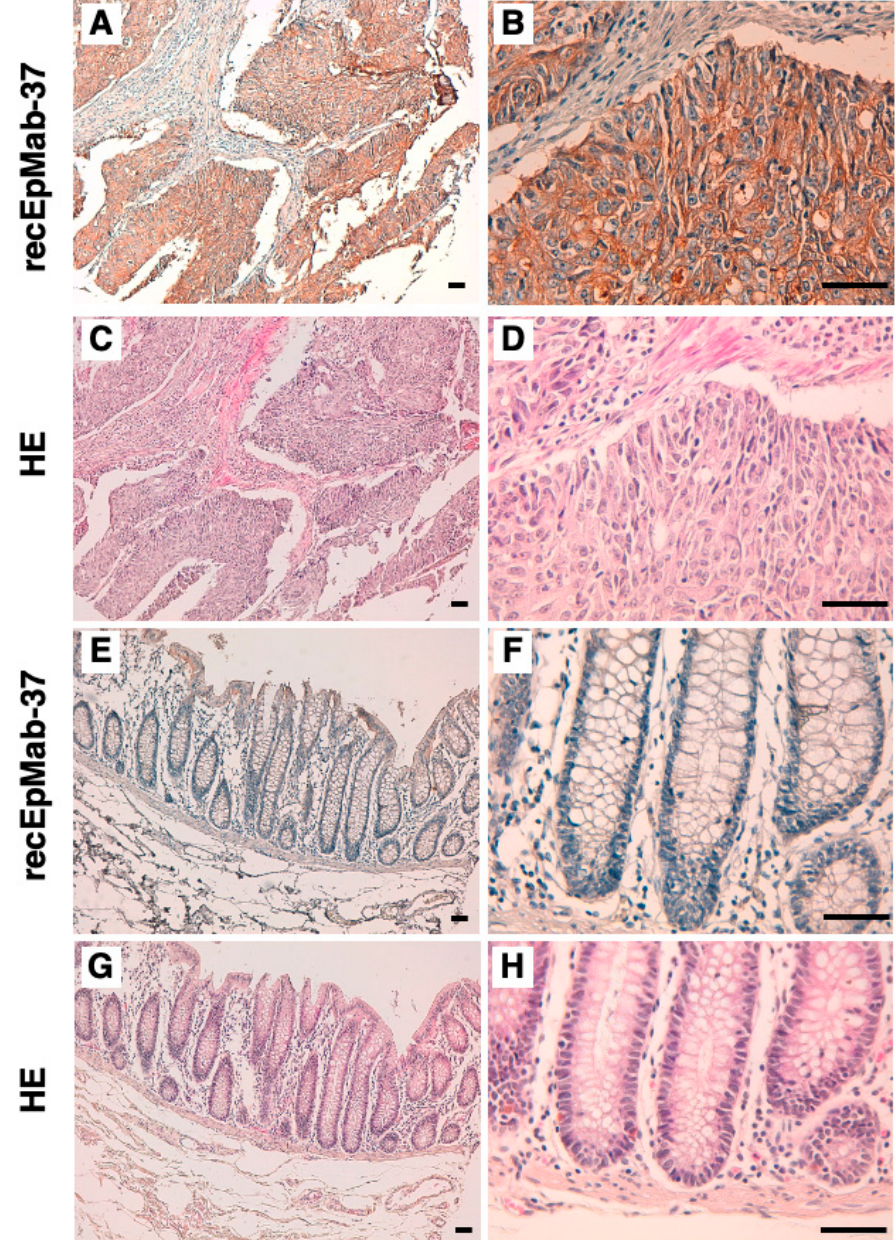
Figure 6. Immunohistochemical analysis using recEpMab-37 against colorectal carcinoma tissues. ( A , B , E , F ) After antigen retrieval, sections were incubated with 1 µ g/mL of recEpMab-37 followed by treatment with the Envision+ kit. Color was developed using DAB, and sections were counterstained with hematoxylin. Cytoplasmic brown staining indicates the EpCAM positive cells. ( C , D , G , H ) Hematoxylin and eosin (HE) staining. Scale bar = 100 μ m.